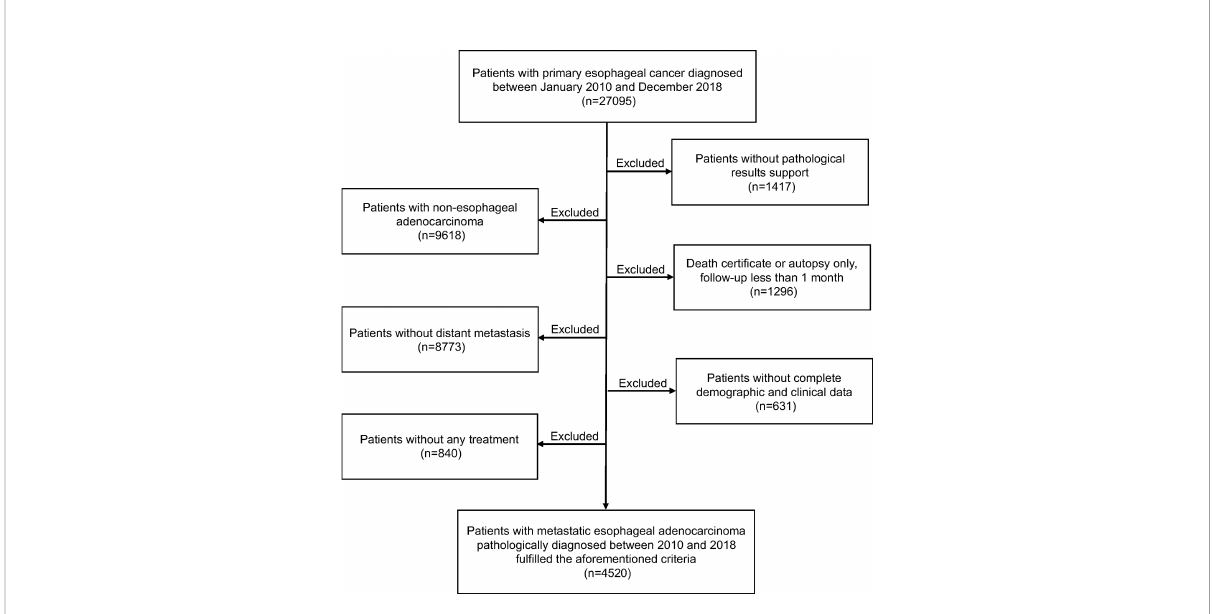
FIGURE 1 Flowchart showing detailed derivation of study population